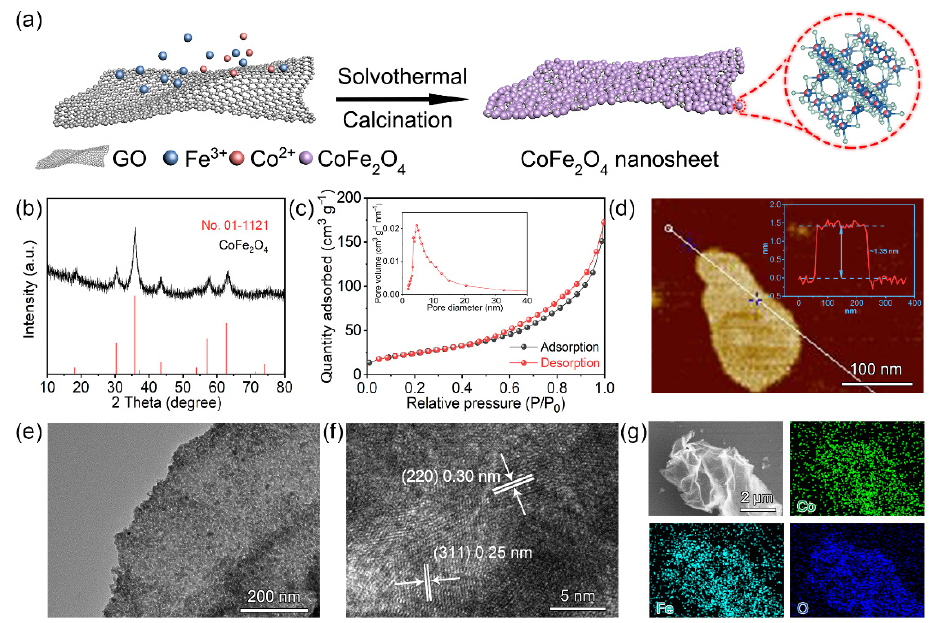
Figure 1. ( a ) Schematic illustration of the preparation processes of CoFe 2 O 4 nanosheets. Phase characterization of the prepared CoFe 2 O 4 : ( b ) XRD; ( c ) N 2 adsorption–desorption isotherm, inset: pore size distribution; ( d ) AFM image and the corresponding height profiles (inset); ( e ) TEM image; ( f ) HRTEM image; ( g ) areal elemental mapping images.